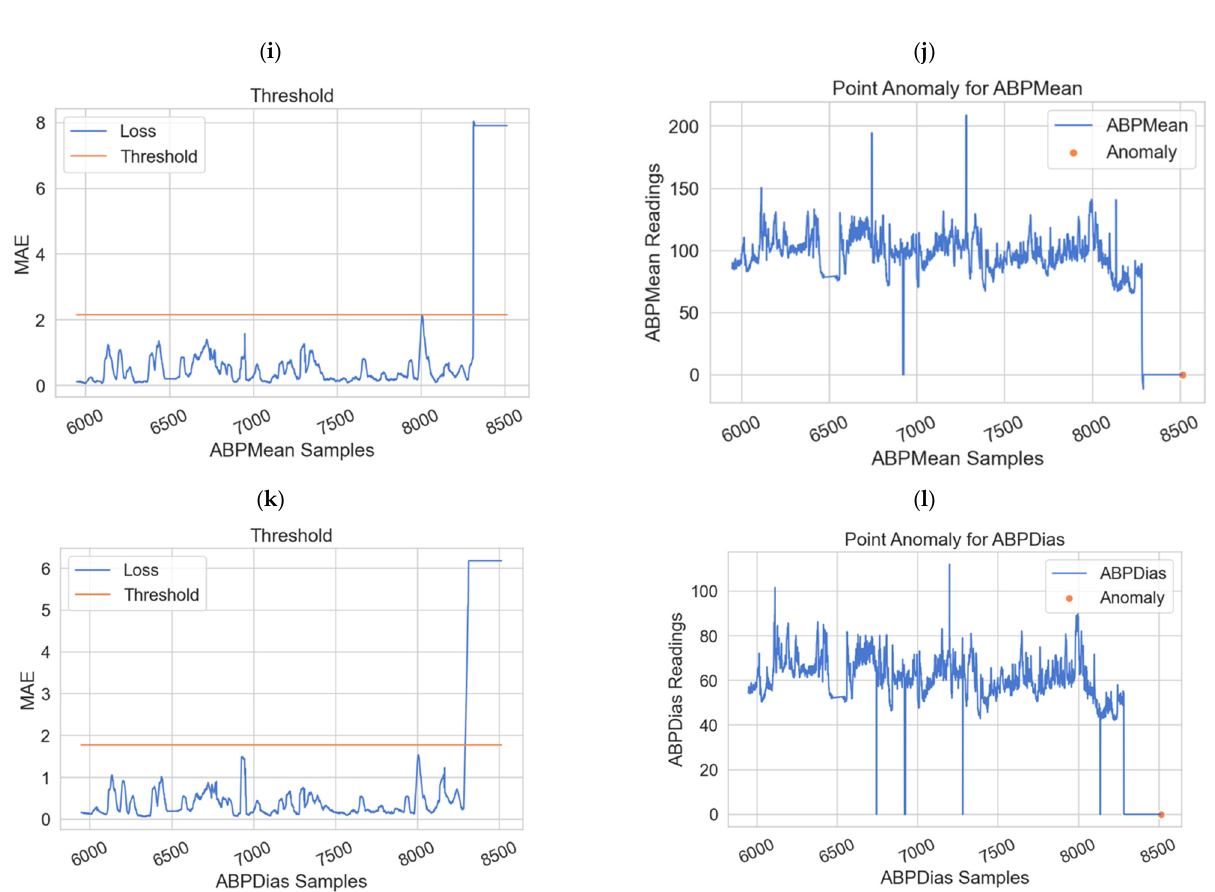
Figure 8. The value of the dynamic threshold and the respective point anomalies for various physi- ological sensors: ( a ) SPO2 threshold. ( b ) SPO2 point anomaly. ( c ) RESP threshold. ( d ) RESP point anomaly. ( e ) Pulse threshold. ( f ) Pulse point anomaly. ( g ) ABPSys threshold. ( h ) ABPSys point anomaly. ( i ) ABPMean threshold. ( j ) ABPMean point anomaly. ( k ) ABPDias threshold. ( l ) ABPDias point anomaly.